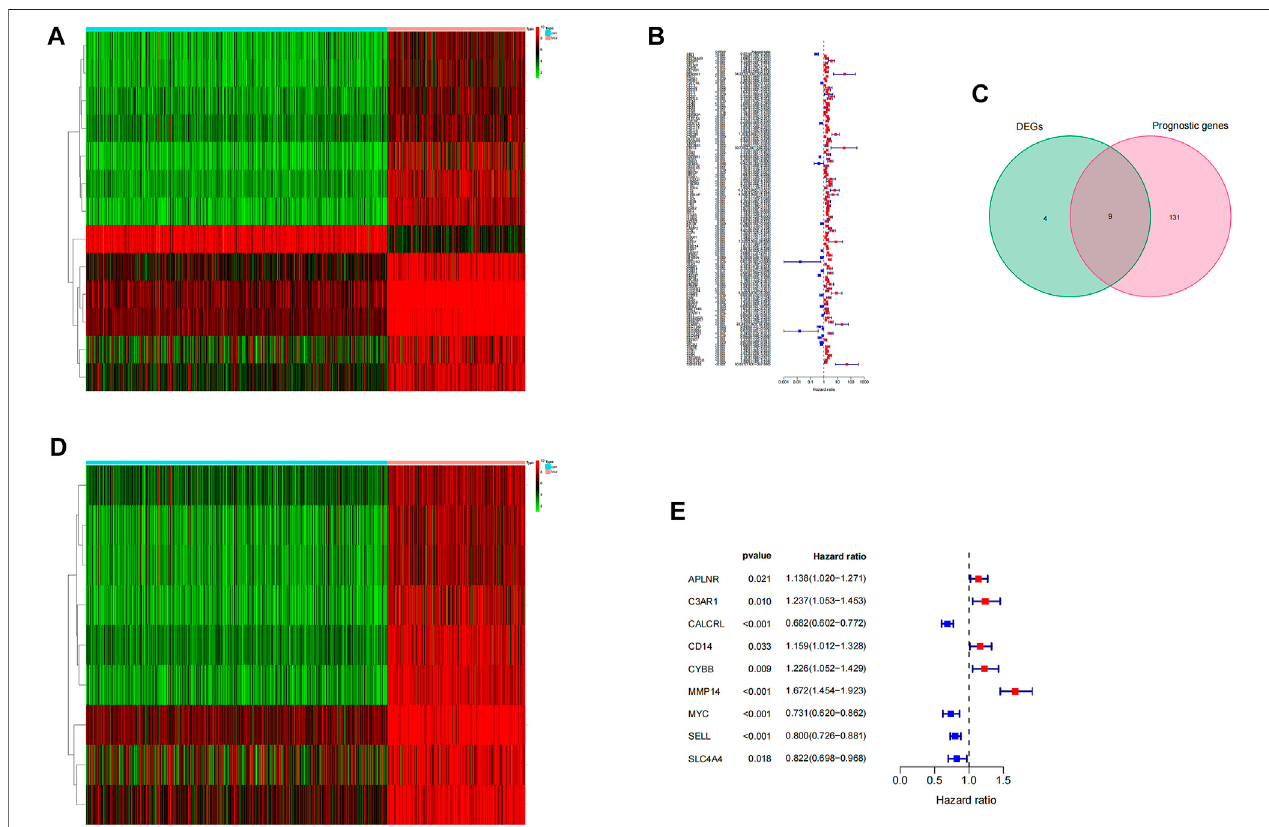
FIGURE1| Screeningofprognosticdifferentialin fl ammatorygenes. (A) Thermalmapofallin fl ammatorydifferentialgeneexpressioninLGGtumortissuesand normal tissues. (B) Based on 200 in fl ammatory genes, the forest map of prognosis-related genes was screened. (C) Wayne diagram of intersection of differential genes and prognosis-related genes. (D) Thermograms of nine prognosis-related in fl ammatory genes. (E) Forest map of nine prognosis-related in fl ammatory genes.